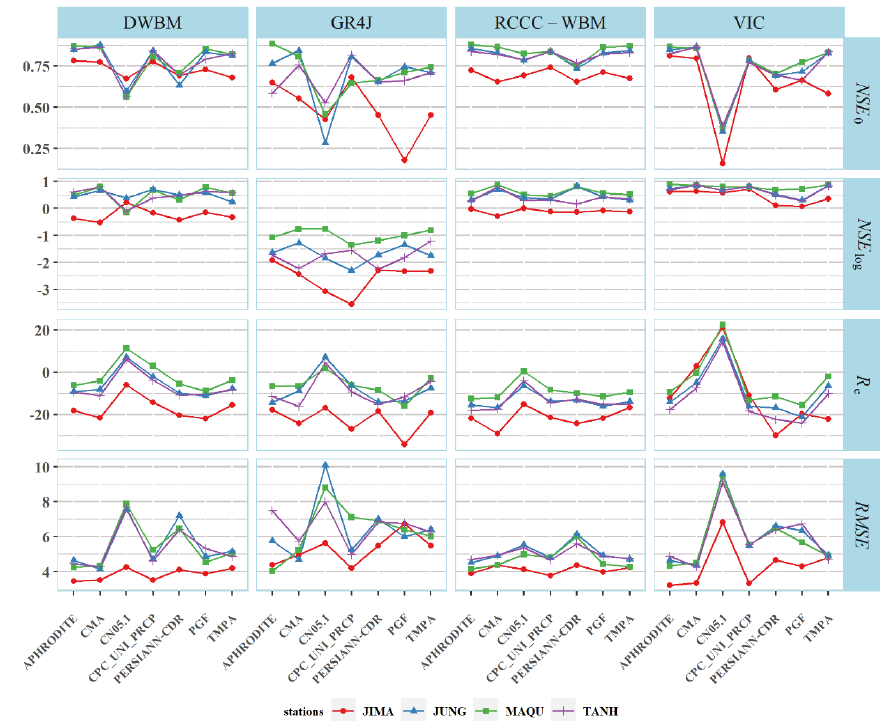
Figure 8. Results of hydrological modeling performance evaluation indices ( NSE 0 , NSE log , R e , and RMSE ) in the validation period (2009–2014) at 4 hydrometric stations (JIMA, MAQU, JUNG, and TANH), using 4 hydrologic models (DWBM, GR4J, RCCC-WBM, and VIC).